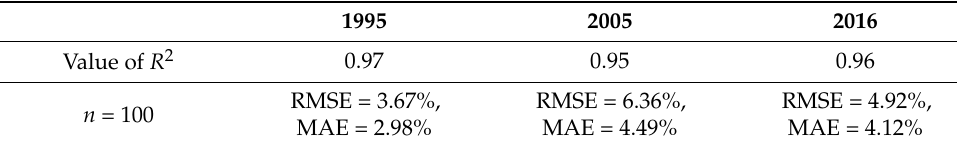
Table 4. The value of R 2 of the Landsat TM image in 1995, 2005, and